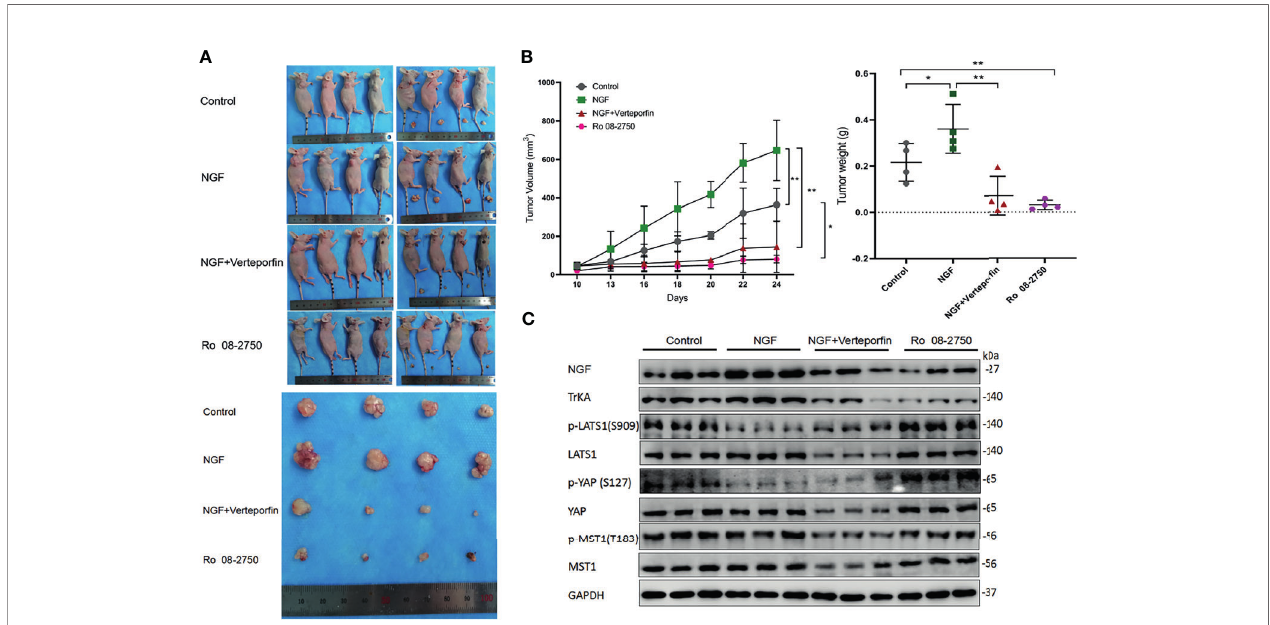
FIGURE 5 | NGF promoted cervical cancer cell-derived xenografttumorsin nudemice by inhibiting the Hippopathway. (A) HeLa cells were injected into the femalenude mice (n = 16);Control group: PBS were injected into the nudemice; NGF group: b -NGF(1,440 ng/daysfor 14 days) was administered subcutaneouslythree times a day for 14 days; NGFwith Vertepor fi n group: b -NGF (1,440 ng/day for 14 days) was administeredsubcutaneously three times a day with vertepor fi n administered intraperitoneally at a dose of100 mg/kg every2 daysfor a total of 2 weeks; Ro 08-2750 group: Ro 08-2750 (13.75 mg/kg)was injected intraperitoneally into the nudemice. Representative images of xenografttumorsare shown. (B) Tumor volume andweightin the xenograftmice fromControl, NGF, NGFwith Vertepor fi n,and Ro 08-2750 groups. Data are shownas themean ± SDin three independent experiments. *P < 0.05, **P < 0.01. (C) Western blot analysis of lysates fromxenografttumors innudemice was performed with anti-NGF, anti-TrkA, anti-p-LATS1, anti-LATS1, anti-p-YAP, anti-YAP, anti-p-MST1, and anti-MST1 antibodies. GAPDHwas usedas a